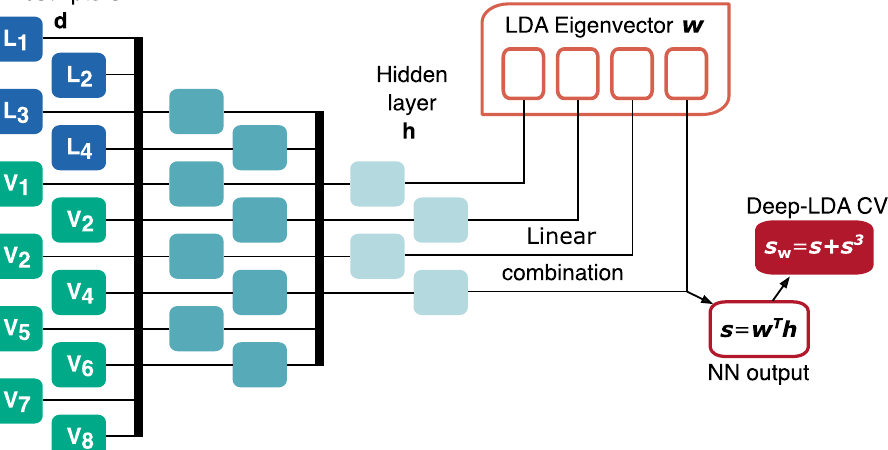
Fig. 2 Schematics of the Deep-LDA architecture used in this work. The descriptors d are fed to a NN that generates s as a linear combination of the last NN hidden layer h and the LDA eigenvector w . The Deep-LDA CV is then s w = s + s 3